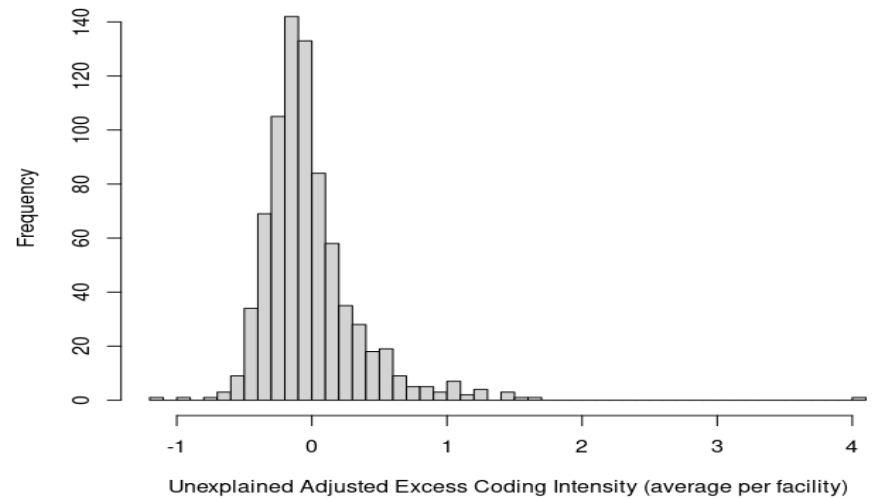
Figure 2. Unexplained adjusted excess coding intensity (AECI) depicted as averages across patient visits per facility for n = 781 facilities.